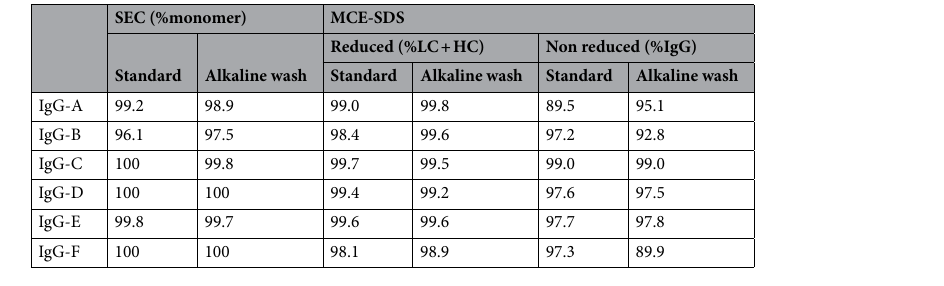
Table 1. Effect of alkaline wash on antibody